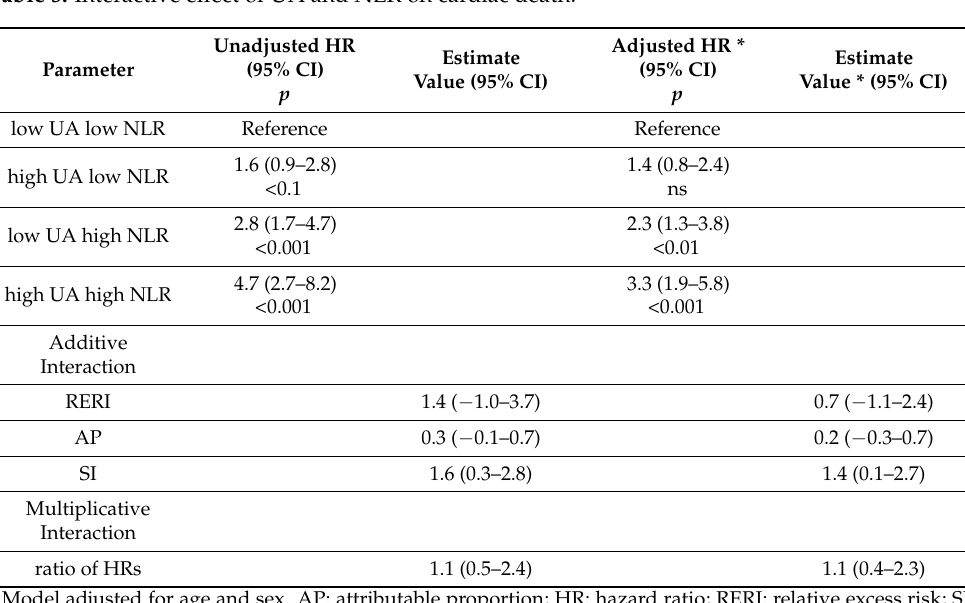
Figure 2. Hazard ratios with contributions from different categories of UA and NLR for cardiac death and hard events. Table 5. Interactive effect of UA and NLR on cardiac